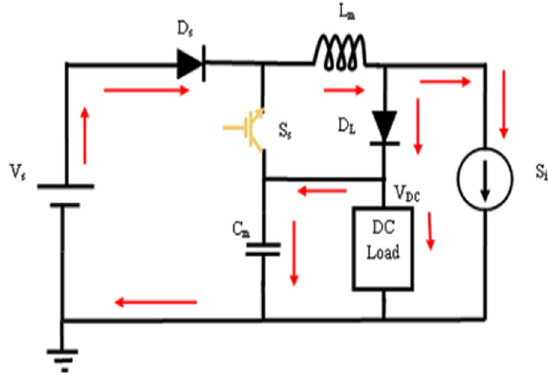
Fig. 4 Operation of inverter in ((1